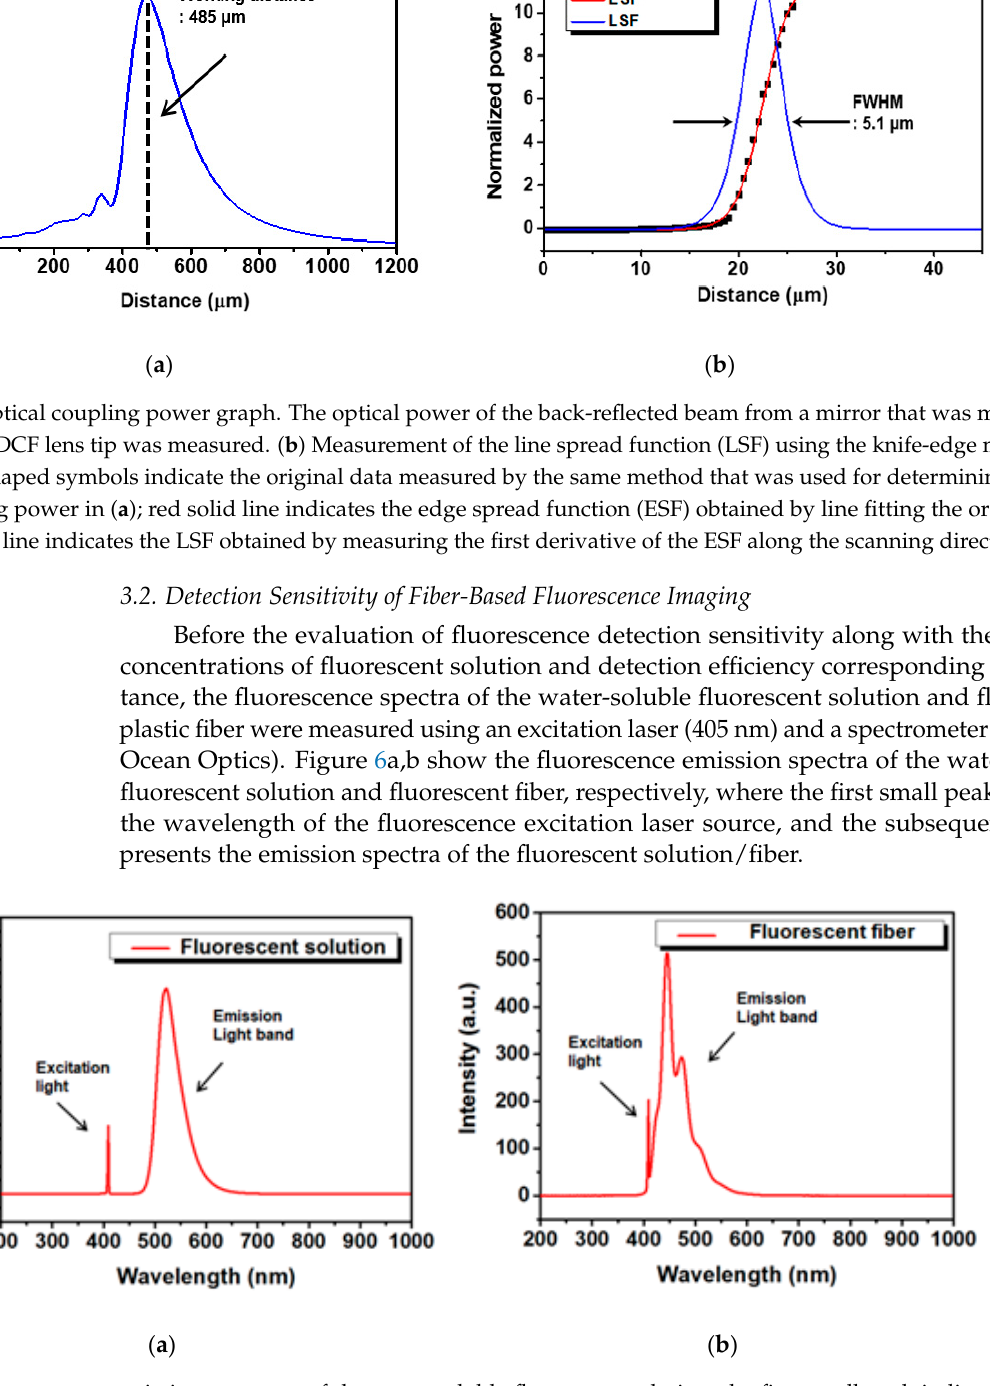
Figure 6. ( a ) Fluorescence emission spectrum of the water-soluble fluorescent solution; the first small peak indicates the wavelength of the fluorescence excitation laser source (405 nm), and the second peak presents the emission spectrum. ( b ) Fluorescence emission spectrum of the fluorescent fiber; the first small peak embedded in the main peak indicates the wavelength of the fluorescence excitation laser source (405 nm), and the other peaks present the emission spectrum of the fluorescent fiber.